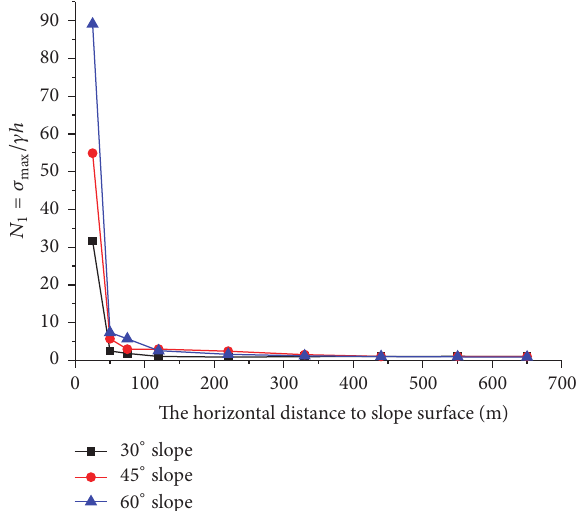
Figure8:Variationcurvesof 𝑁 1 attheelevationof100 mindifferent slope angles when the lateral pressure coefficient is equal to 1.5.